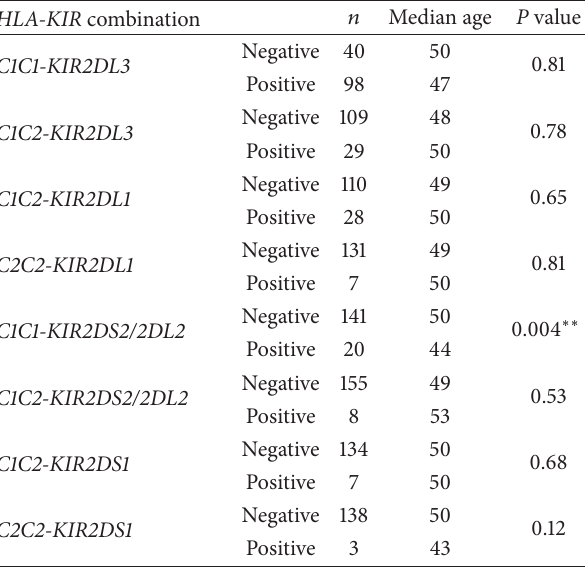
Table 3: Effects of HLA-C-KIR ligand-receptor combinations on the onset age of HCC by KM analysis.